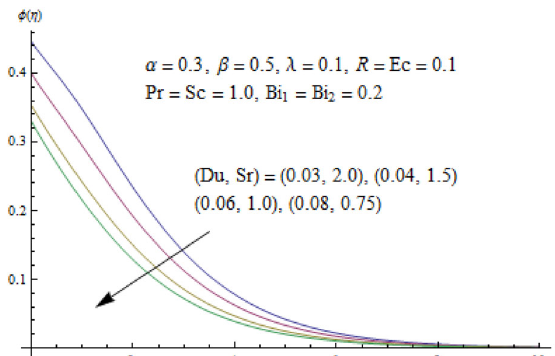
Fig. 20 Impact of (Du, Sr) on φ(η)